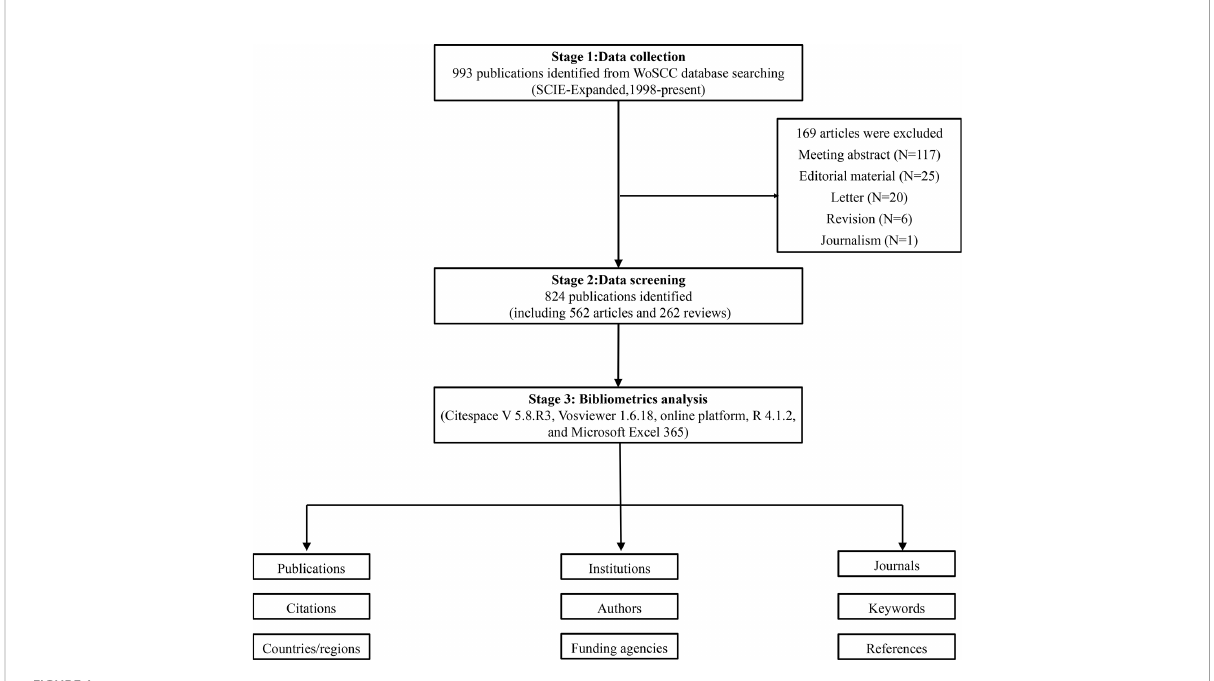
FIGURE 1 Flowchart of the literature search and selection